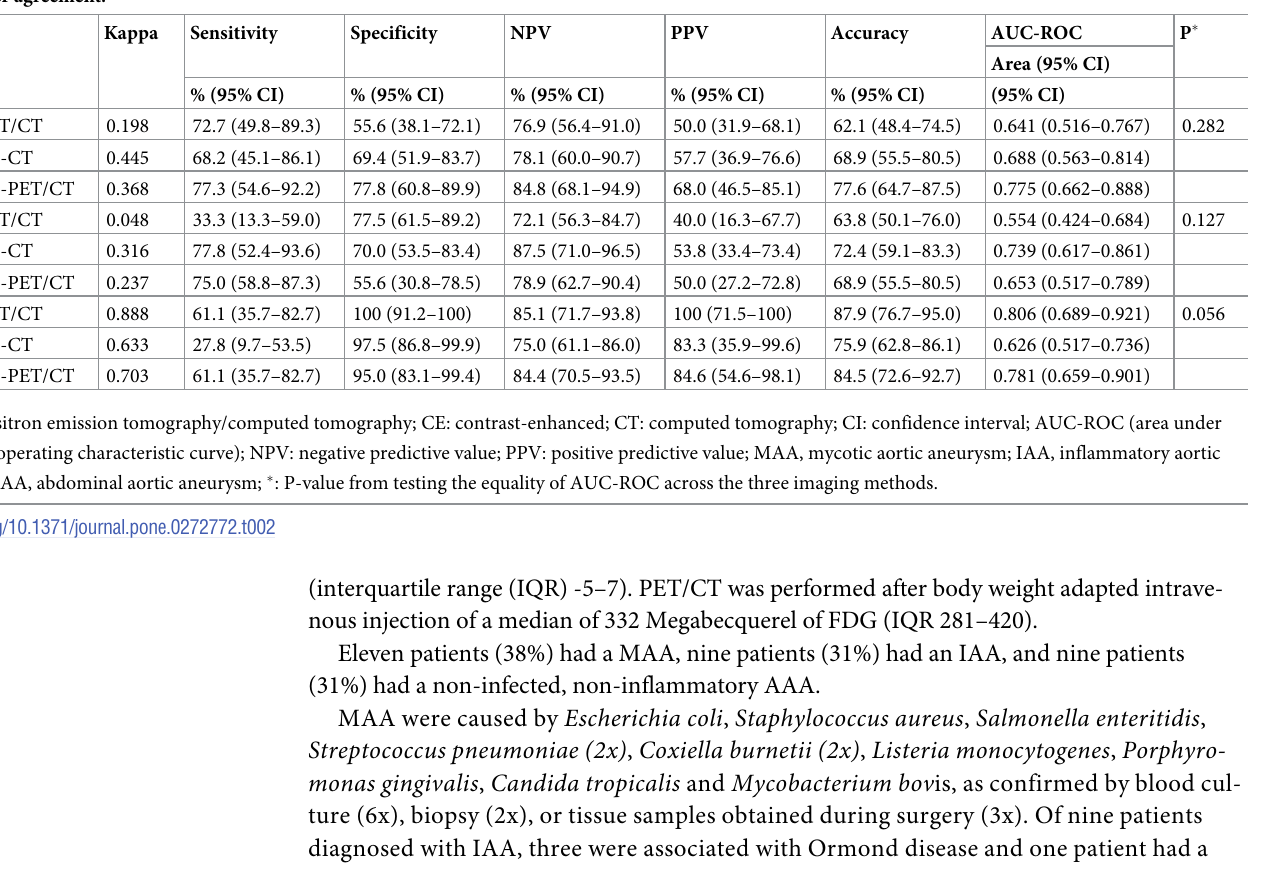
Table 2. Diagnostic accuracy of PET/CT, CE-CT, combined CE-PET/CT for diagnosis of MAA, IAA and AAA—combined for both readers, and Kappa statistics of the interrater